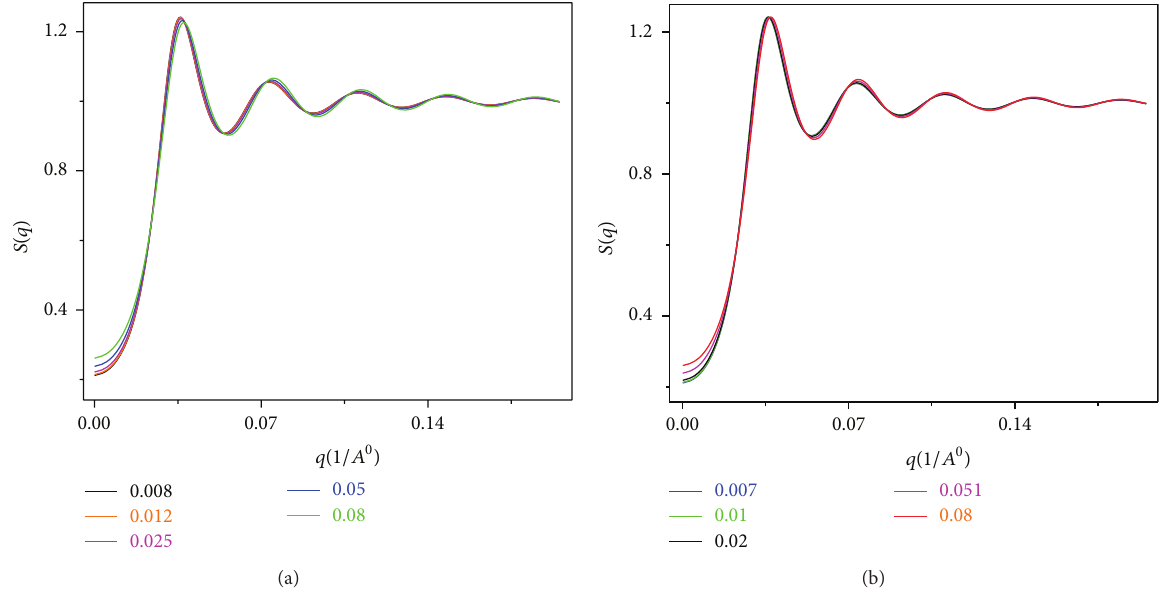
/𝑚 = 1.08 Dec C 12 E 5